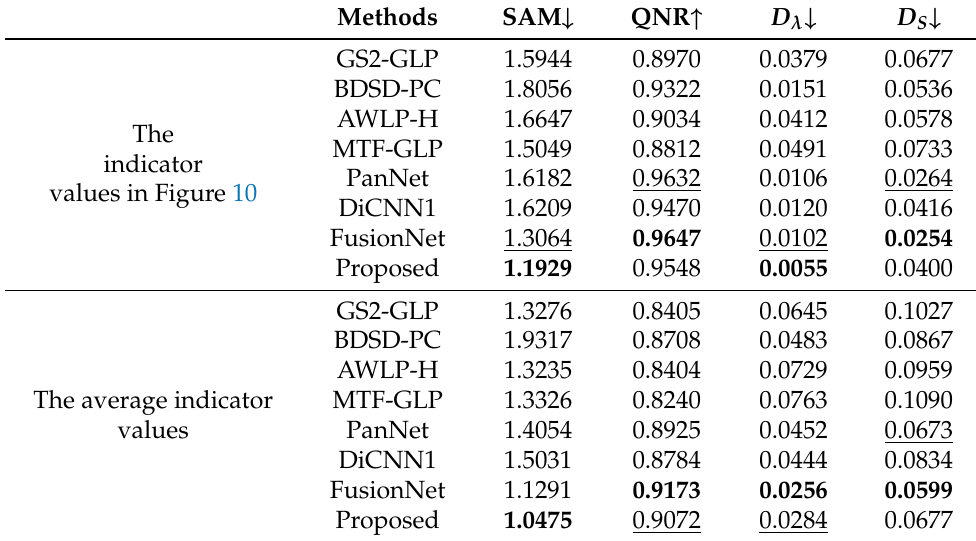
Table 11. Comparison of indicator evaluation results on the full-resolution WorldView-3 dataset.